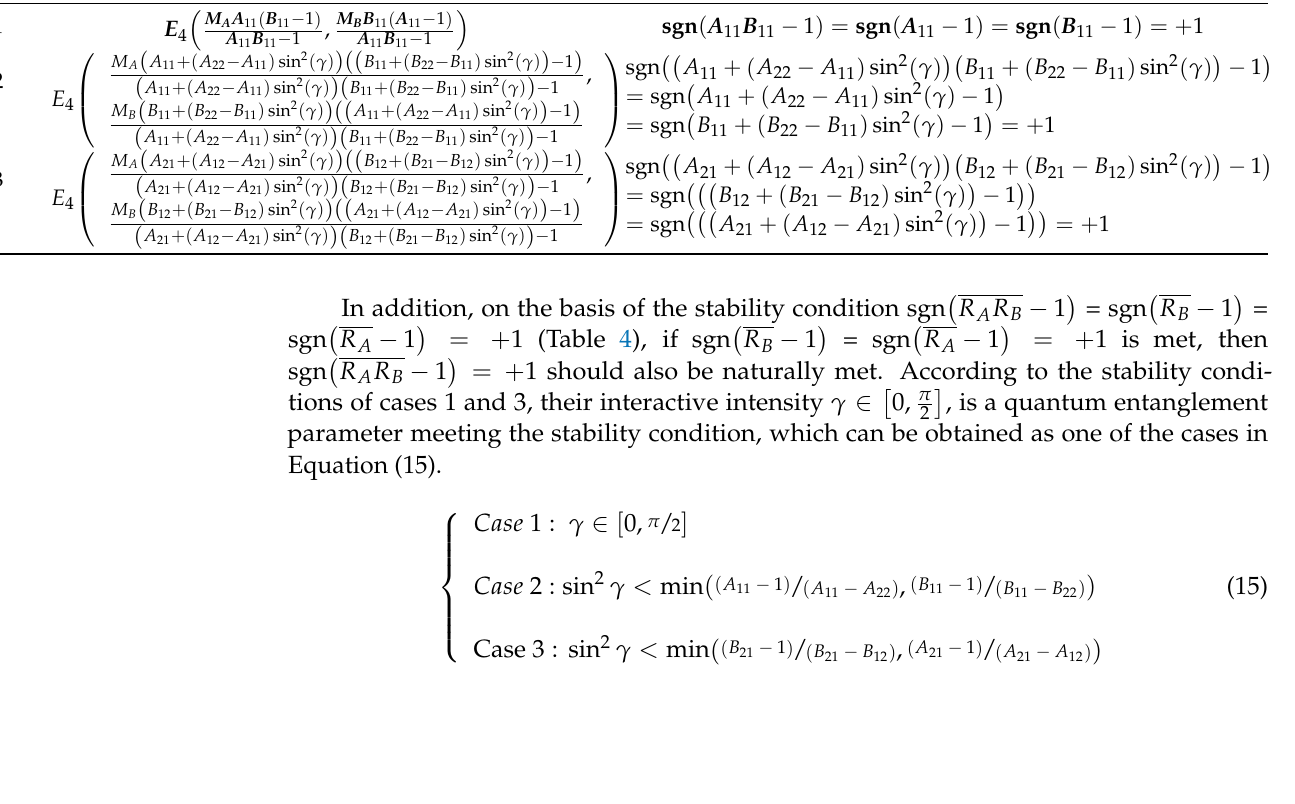
Table 4. Stability conditions for coexistence equilibrium by case for the competition scenario. Equilibrium Stability